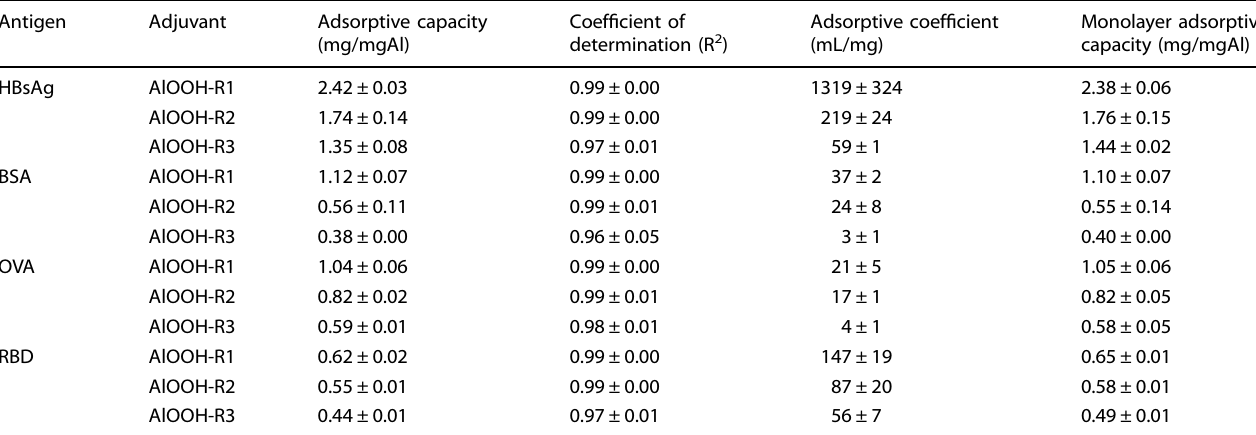
Table 2. Adsorption parameters for HBsAg, RBD, OVA, and BSA by AlOOH